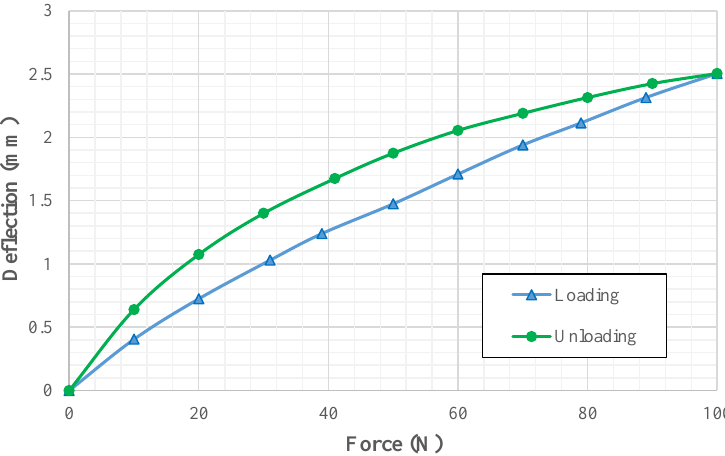
Figure 14. Experiment results: deflection vs. force for sensing element (only) using a force